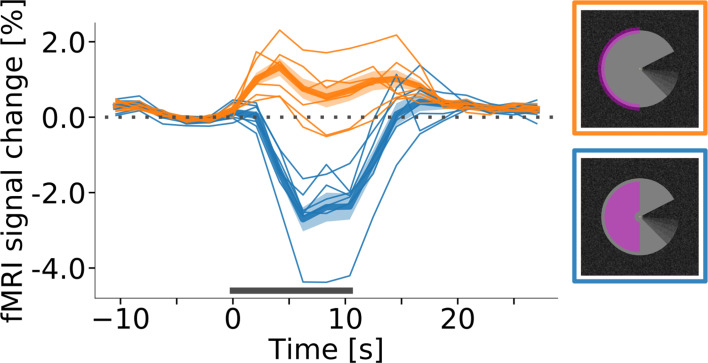
Single-subject response onset times in V1.Event-related fMRI timecourses for regions of interest corresponding to the stimulus centre (blue line) and the edge of the stimulus (orange line). Same as Figure 5, but with single-subject timecourses (thin lines) overlaid on group average (thick lines).